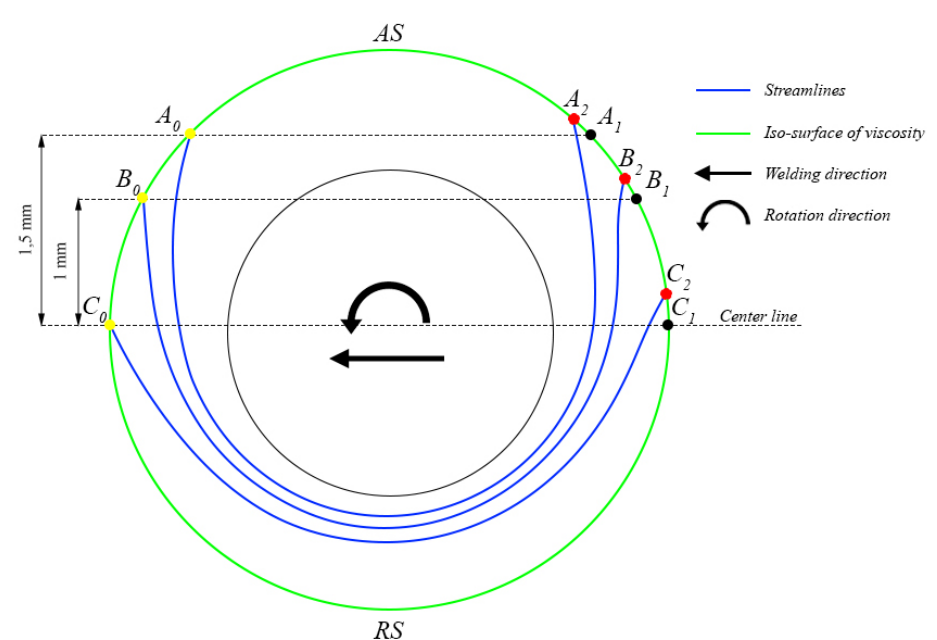
Figure 15. Scheme of “pseudo strain” calculation for the cylindrical probe profile. Table 4. “Pseudo strain” values.